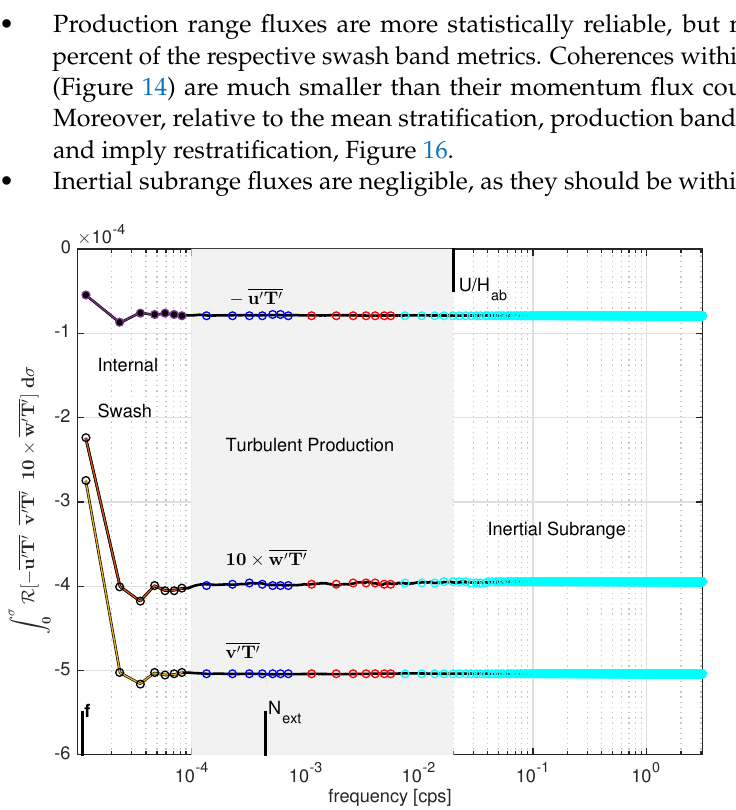
Figure 13. Running integrals of temperature fluxes in three dimensions: ( −(cid:60) ( u (cid:48) T (cid:48) ) ; (cid:60) ( v (cid:48) T (cid:48) ) ; 10 × (cid:60) ( w (cid:48) T (cid:48) )) .